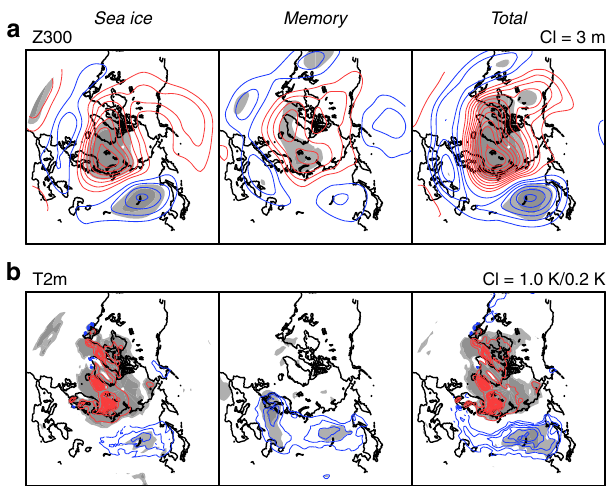
Fig. 2 Simulated winter atmospheric responses to sea ice reduction. Winter (December – February) averaged anomalies of a geopotential height at 300 hPa (Z300) with a contour interval (CI) of 3 m and b temperature at 2 m height (T2m) with a contour interval of 1.0 K for positive anomalies and 0.2 K for negative anomalies. From left to the right, 100-year averages of sea ice, memory, and total effects are shown. Red and blue indicate positive and negative anomalies, respectively, and light and heavy gray shading indicate statistical signi fi cance exceeding 95 and 99%, respectively